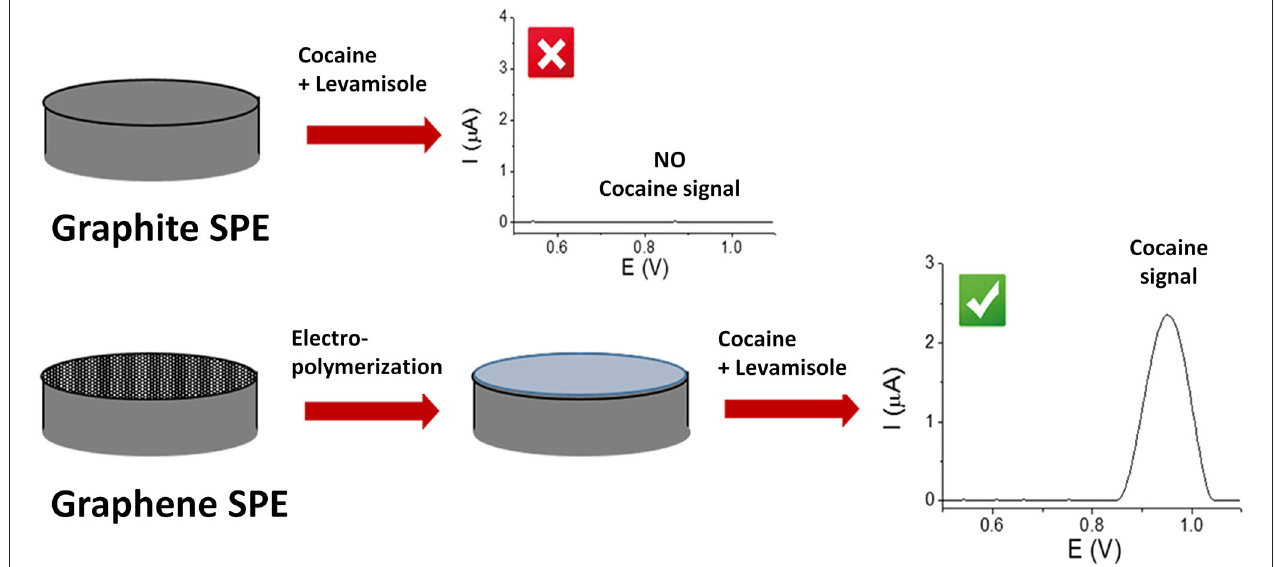
FIGURE 4 | The principle of working of a polymer-based sensor for the detection of cocaine in presence of levamisole. Florea et al. (2018) with permission from Talanta.